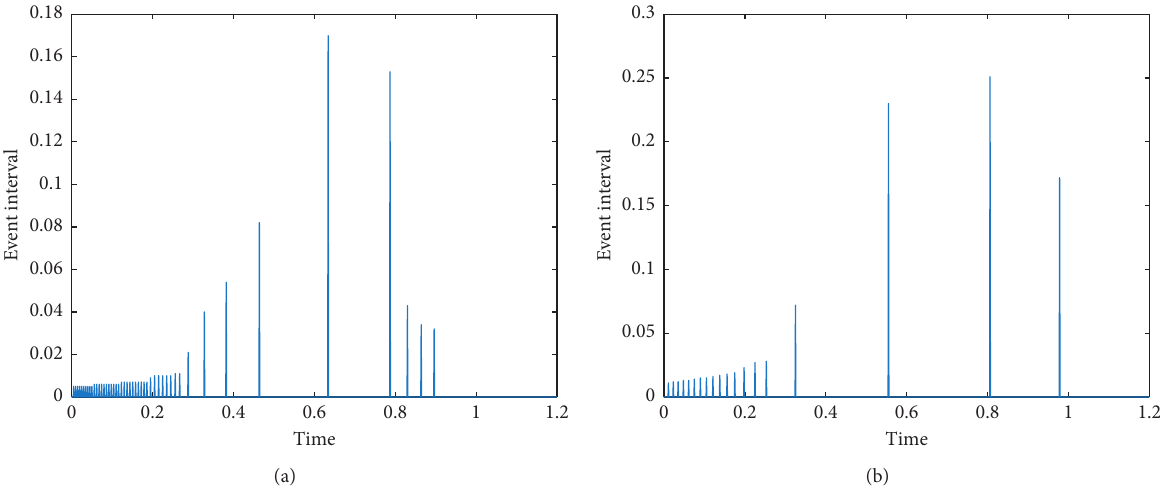
Figure 8: Release instants and event intervals under triggering condition (54) with ω � 0 . 25 and ω � 0 .